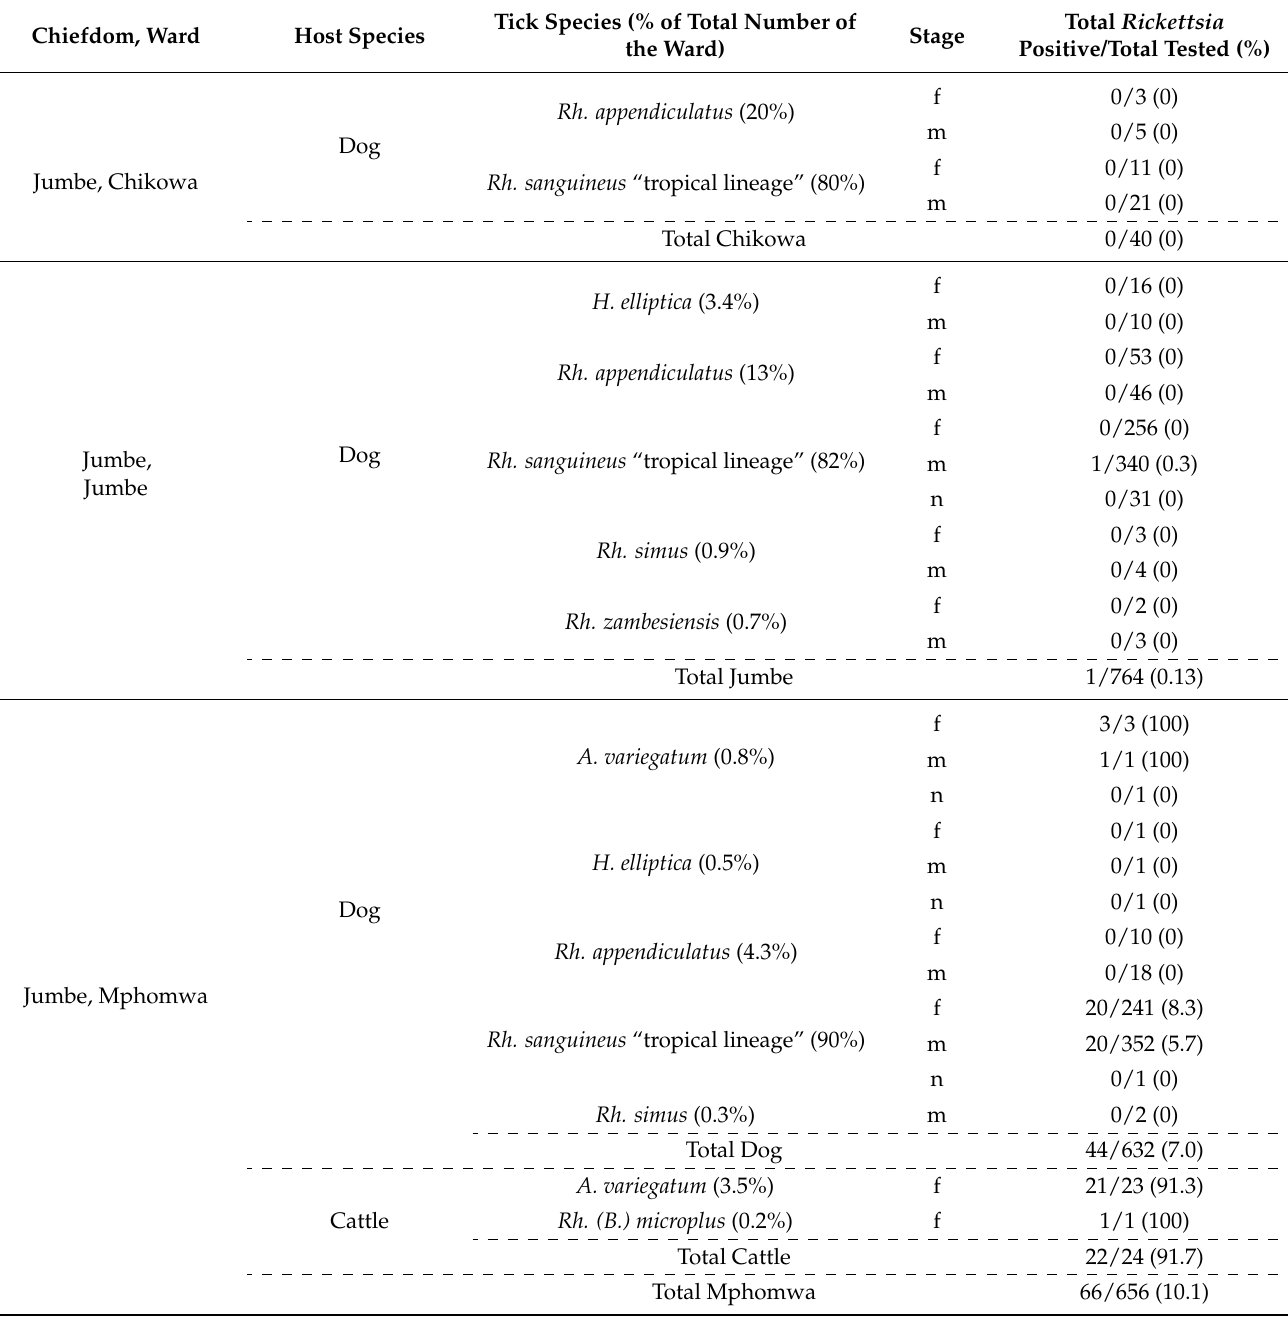
Table 3. List of specimens with collection site, host, tick species, stage and the result of pan- Rickettsia